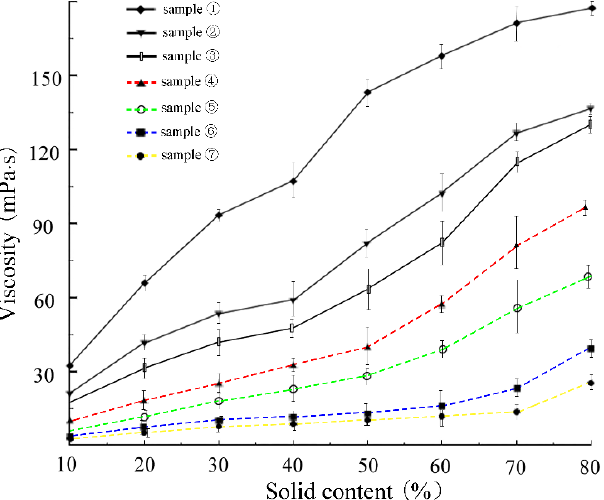
Figure 2. Effect of the E51 to ED ratio on the viscosity of coatings with different solid contents.